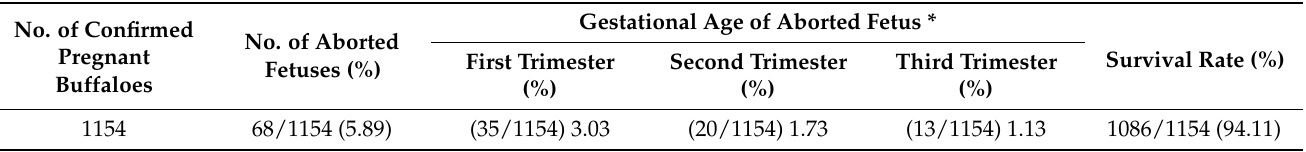
Table 1. The prevalence of pregnancy, occurrence of abortion and survival rates in three private farms in Al-Sharkia. No. of Confirmed Pregnant